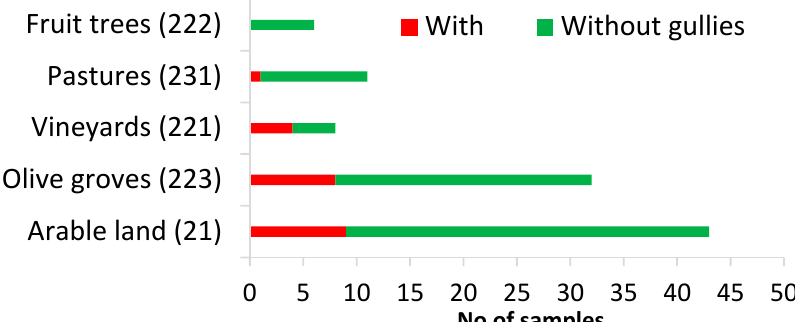
Figure 7. Number of samples found with and without ephemeral gullies (CORINE coding in brackets).